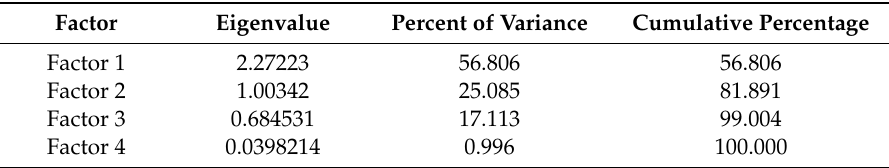
Table 3. Factor Table 3. Factor analysis.